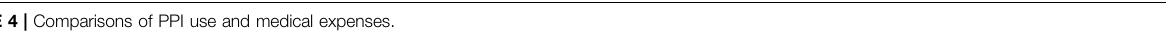
TABLE 4 | Comparisons of PPI use and medical expenses.